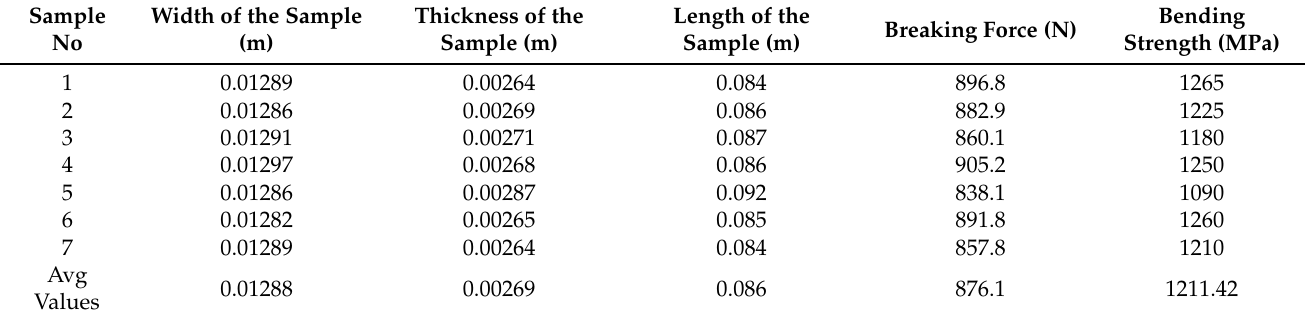
Table 4. Bending strength evaluation of T700 carbon fiber/epoxy